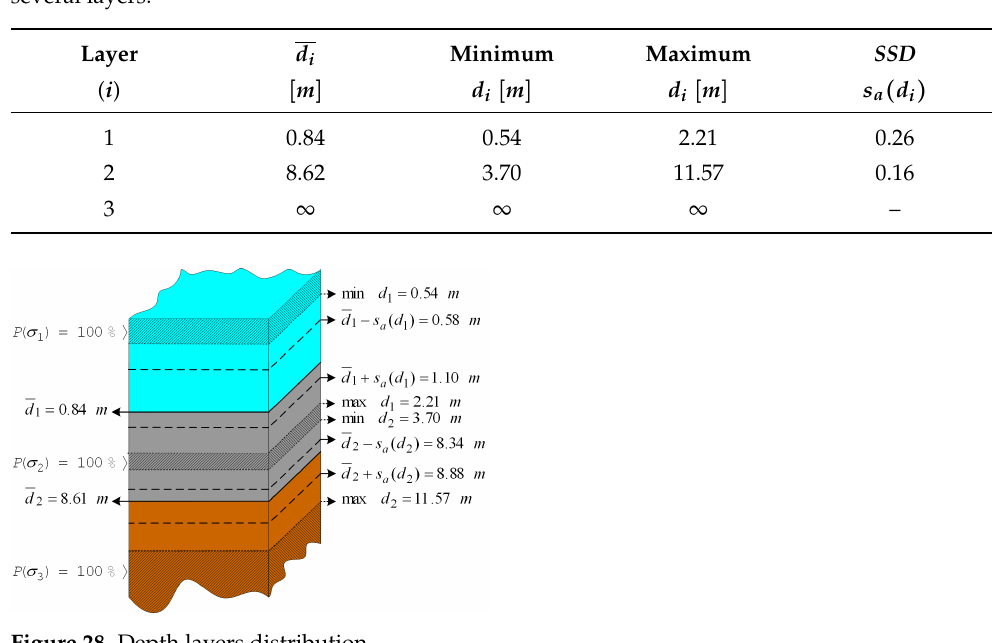
Figure 28. Depth layers